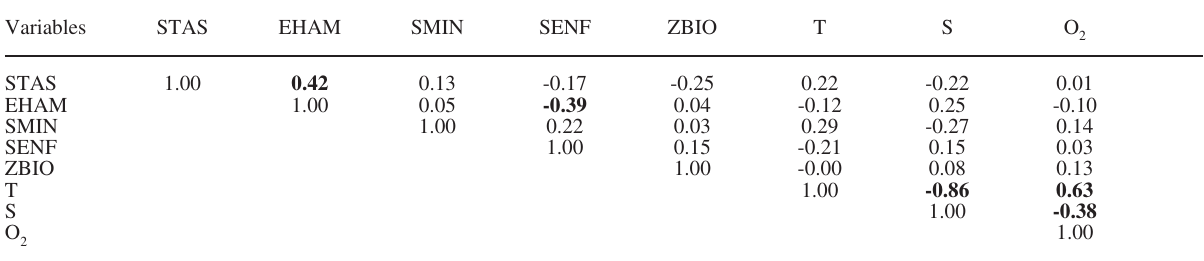
Table 2. – Pearson’s correlation analysis between the relative abundance of the species with a frequency >50% in the study area and the ocea- nographic parameters. Significant values in bold ( α = 0.05). STAS: Sagitta tasmanica , EHAM: Eukrohnia hamata , SMIN: S. minima , SENF: S. enflata , ZBIO: Zooplanktonic biomass, T: temperature, O : dissolved oxygen, and S: salinity. 2 Variables STAS